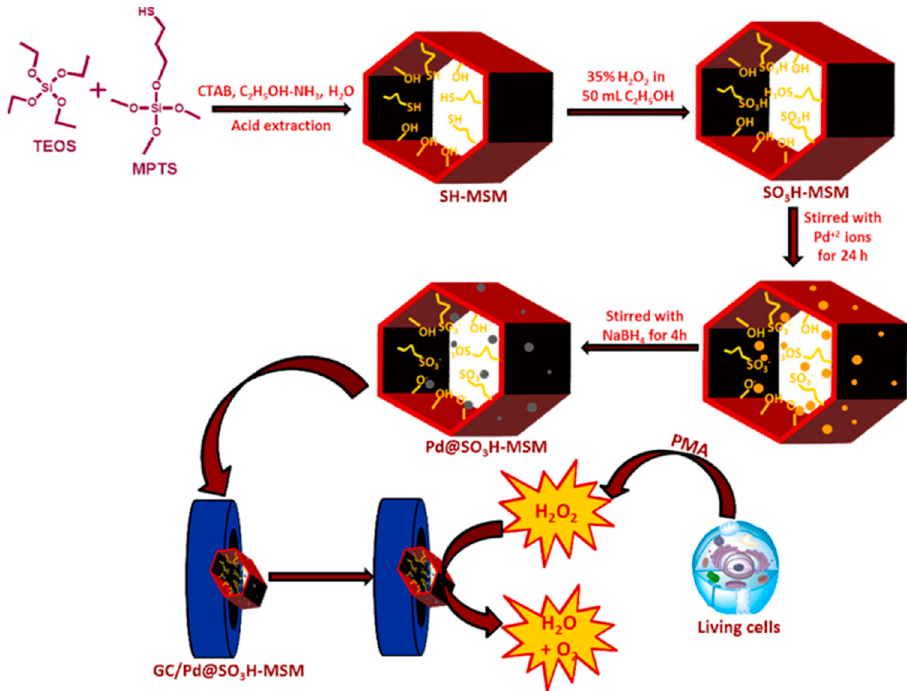
Figure 5. Scheme of a Pd@SO 3 H-MSM-modi fi ed H 2 O 2 sensor [51]. Copyright: Elsevier